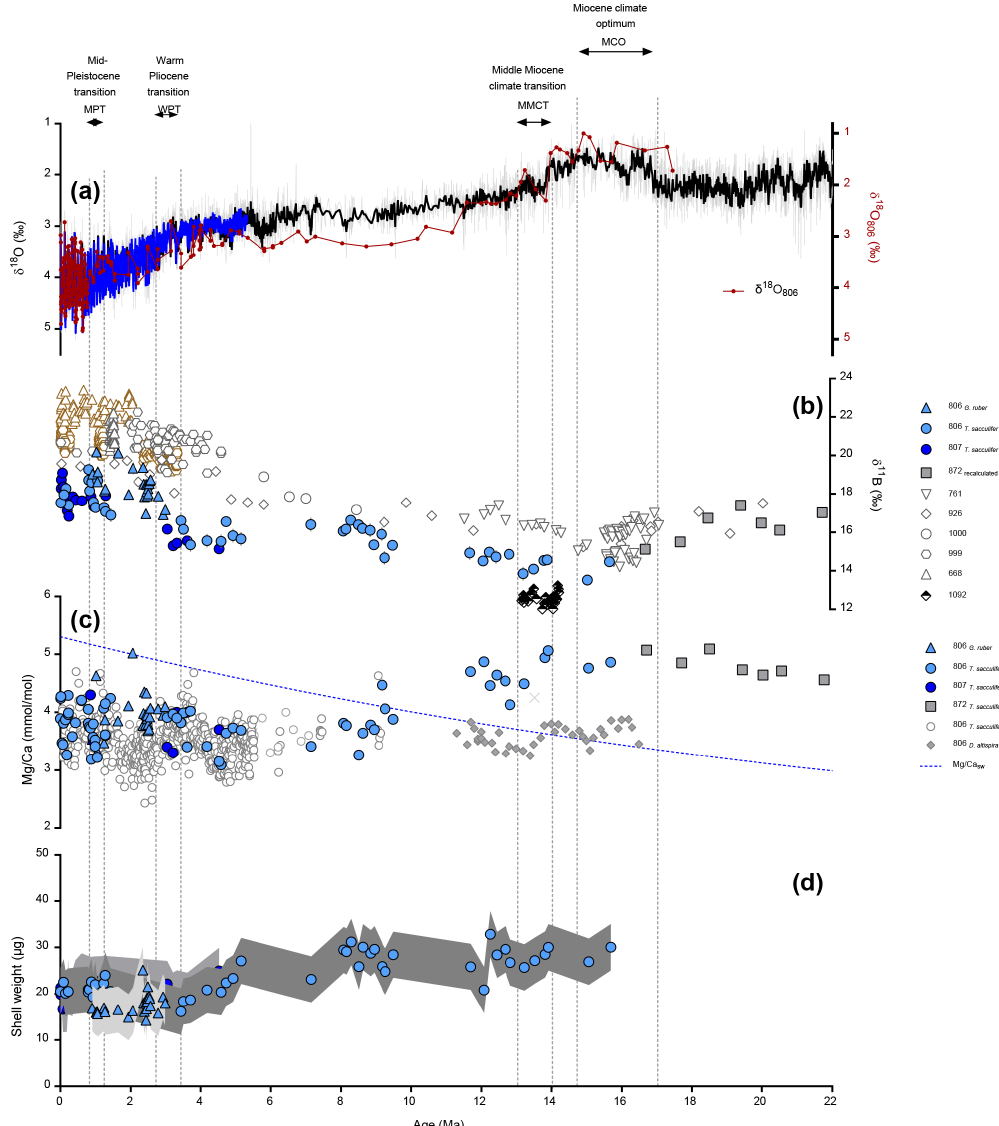
Figure 2. Foraminiferal data for Miocene to recent times. (a) Benthic foraminiferal δ 18 O data (blue line – stack from Lisiecki and Raymo, 2005; black line – compilation from Zachos et al., 2008; red line – compilation from Lear et al., 2015, 2020, at Site 806). (b) δ 11 B of T. sacculifer (blue circles) and G. ruber (blue triangles) at Sites 806 (light blue) and 807 (dark blue). Grey filled squares represent data from Site 872 located in the WEP (Sosdian et al., 2018). Open symbols are δ 11 B data from published studies (Hönisch and Hemming, 2009; Seki et al., 2010; Foster et al., 2012; Greenop et al., 2014; Martínez-Botí et al., 2015a; Chalk et al., 2017; Dyez et al., 2018; Sosdian et al., 2018; de la Vega et al., 2020; Raitzsch et al., 2021), grey open symbols are T. sacculifer , brown open symbols are for G. ruber . (c) Mg / Ca ratios of T. sacculifer and G. ruber at Sites 806 and 807 and fourth-order polynomial regression from Sosdian et al. (2020) representing secular variations of Mg / Ca sw (blue dotted line). (e) Calculated weight per shell for T. sacculifer and G. ruber . For panels (b) – (d) : circles = T. sacculifer , triangles = G. ruber . Plots realized using GraphPad Prism version 7.0.0 for Windows, GraphPad Software, San Diego, California,